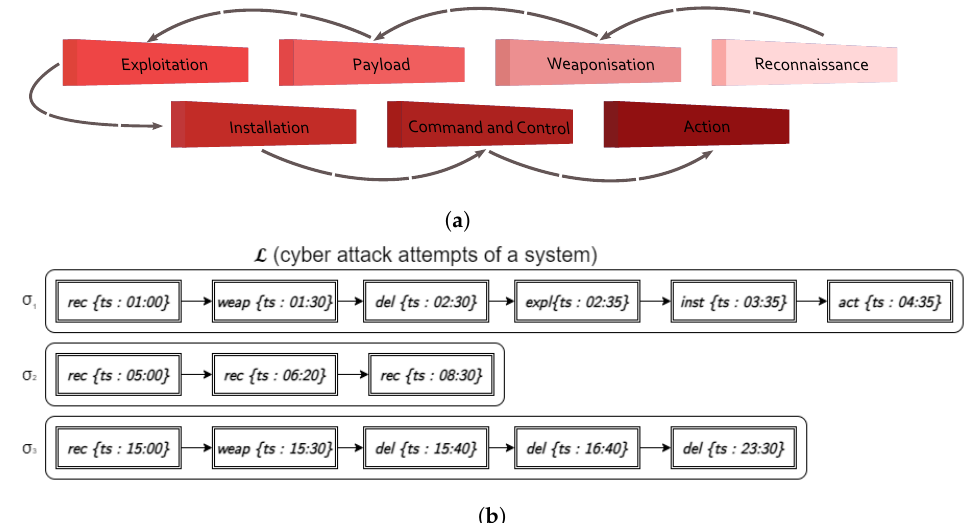
Figure 3. We can express a cyber-security scenario by considering ( a ) possible situations in a Cyber Kill Chain, than are then ( b ) represented in the activity labels’ names associated to the